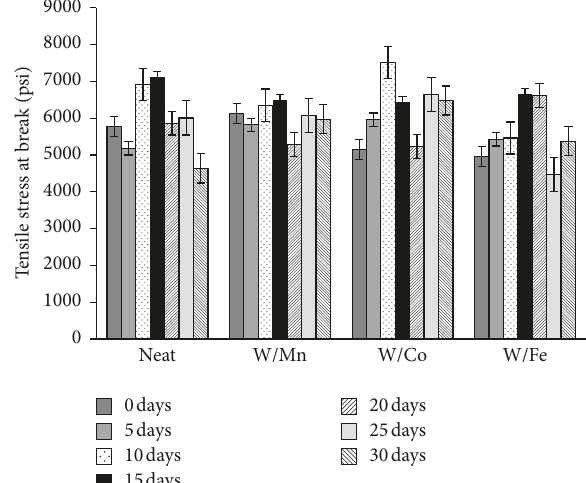
Figure 15: Tensile stress at break of Apel 6509 COC neat and formulated films with different POA.